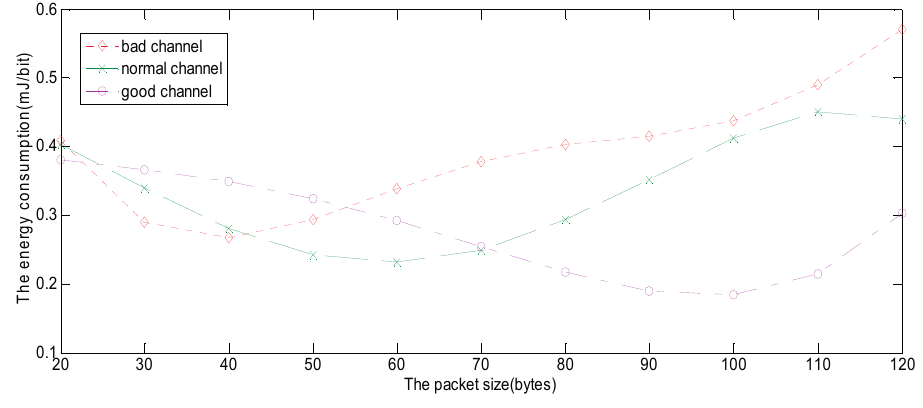
Figure12. The optimal packet size in the different channel